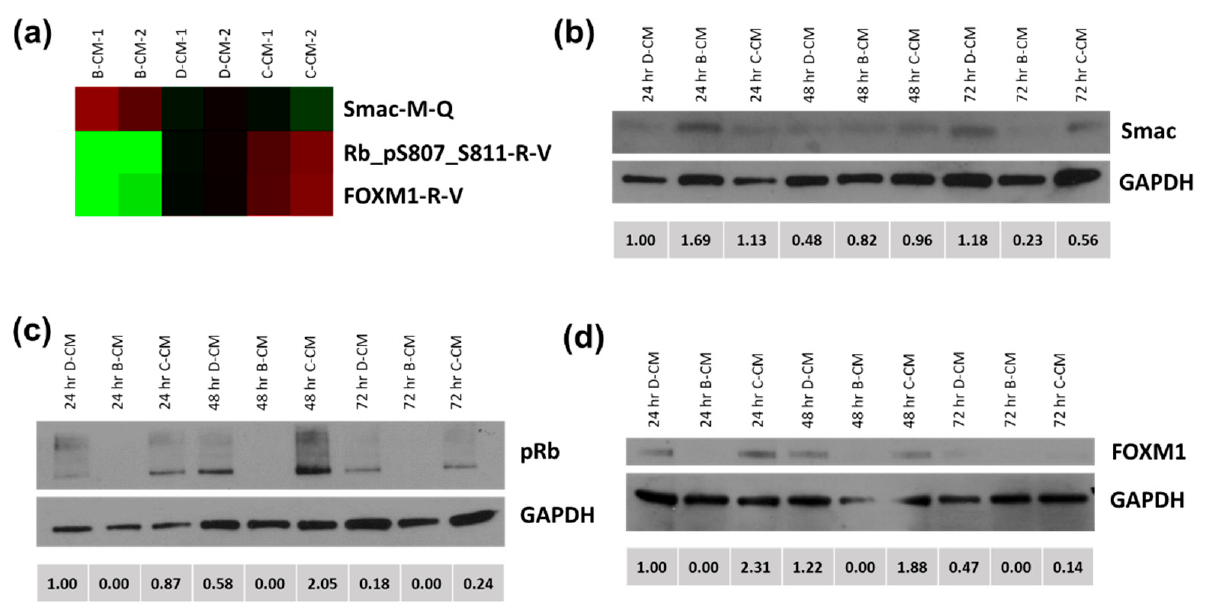
Figure 6. BMEC-conditioned media selectively suppresses phosphorylation of Rb and expression of Smac and FOXM1 in C4-2 cells. RPPA analysis of BMEC (B-CM)-, HMEC (D-CM)-, and C4-2 (C-CM)-conditioned medium treatment of C4-2B cells showed differential expression of signaling molecules pRb, Smac, and FOXM1 (downregulated proteins = green; upregulated proteins = red) ( a ). B-CM treatment showed differential expression of Smac ( b ), pRb ( c ), and FOXM1 ( d ) across time and between control treatment groups (D-CM and C-CM) quantified via densitometry below each corresponding blot.